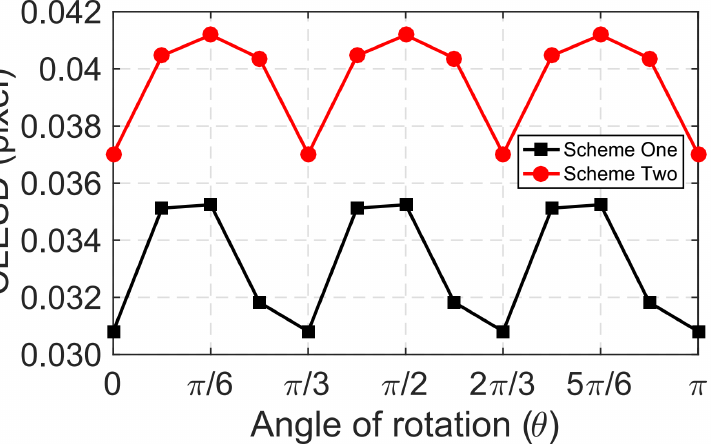
Figure 6. The FOP was rotated π counterclockwise with the relative initial position as the center. The connection between the rotation angle θ and the CLESD of the two FOP schemes was established separately. Scheme one: d f = 4 µ m, K = 0.7; scheme two: d f = 6 µ m, K =